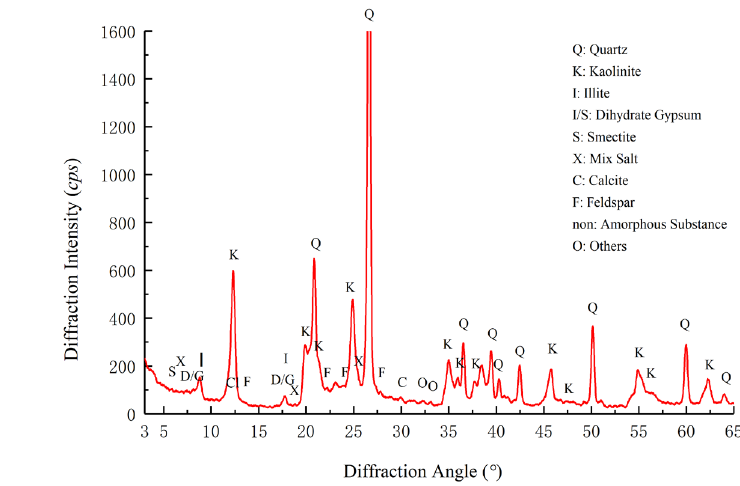
Figure 12. X-ray analysis of the samples.